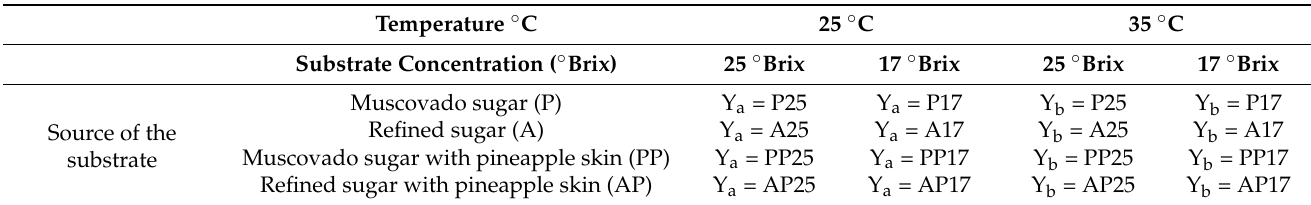
Table 1. Design of experiments of the culture conditions of the grains of water kefir growth kinetics and pH. Temperature ◦ C 25 ◦ C 35 ◦ C Substrate Concentration ( ◦ Brix) 25 ◦ Brix 17 ◦ Brix 25 ◦ Brix 17 ◦